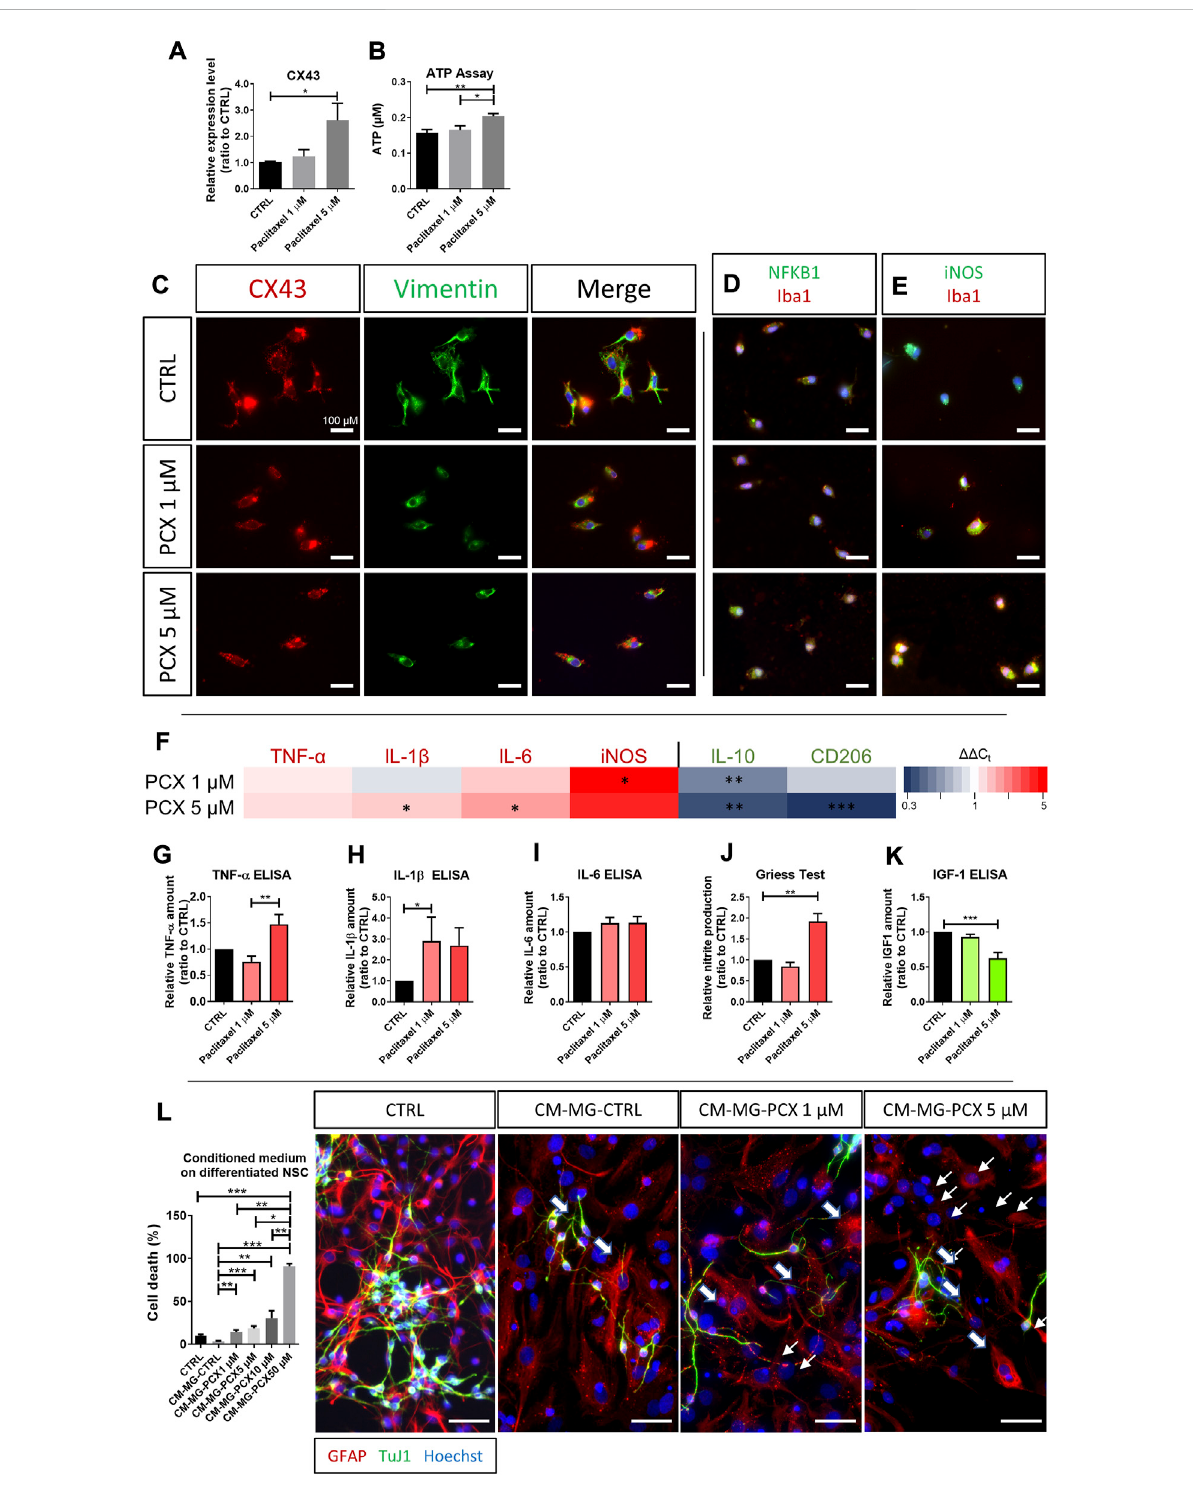
FIGURE 4 Effects of paclitaxel on microglia. (A) Relative expression level of Connexin (CX43) in microglia after 1 μ M and 5 μ M paclitaxel exposure compared to control ( n (number of independent cell culture preparations) = 6). (B) Released adenosine triphosphate (ATP) in μ M after paclitaxel exposure with 1 μ Mand 5 μ Mcomparedto unexposed(CTRL) cells ( n (number of biological replicates) = 10). (C) Immuno fl uorescence micrographs of CX43 and vimentin in microglia after no exposure (CTRL) or exposure to 1 μ M and 5 μ M paclitaxel (PCX). (D) Immuno fl